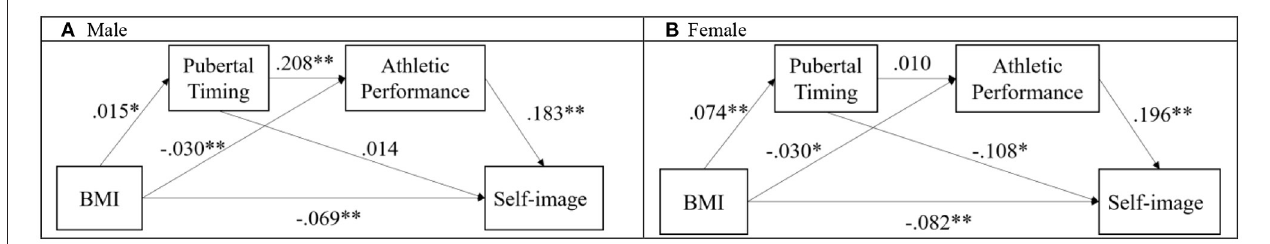
FIGURE 1 | Mediation analysis on pubertal timing and athletic competence in the association between BMI and self-image stratified into male (A) and female (B) samples. * p < 0.05; ** p < 0.01; BMI indicates body mass index.